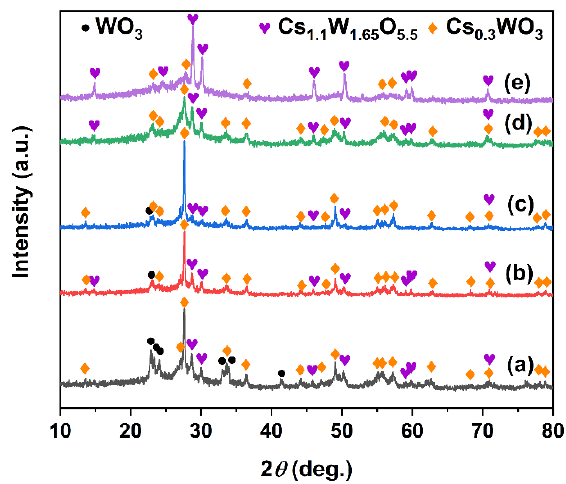
Figure 8. The XRD patterns of the samples synthesized hydrothermally at 200 °C for 24 h using 0.18 mmol CsCl, 0.4 mmol WO 3 , 8.8 mmol CH 3 CH 2 CHO, 4.0 mmol NH 4 COOCH 3 , and ( a ) 0.7; ( b ) 1.4; ( c ) 2.1; ( d ) 2.8; ( e ) 3.5 mmol NH 3 ‧ H 2 O.